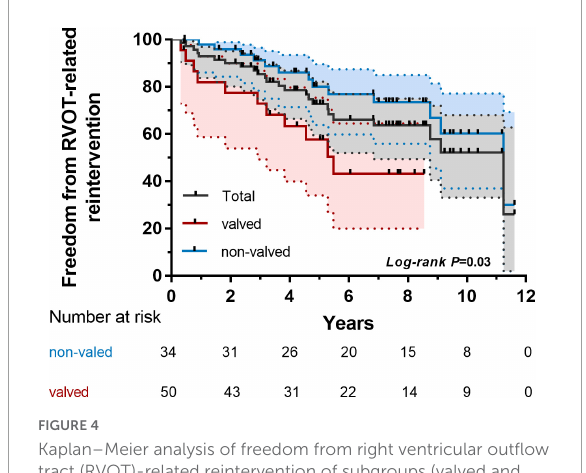
could be performed when the infant grows up. There was always a pendulum between the choice of reducing the reintervention rate and preservation of right ventricular